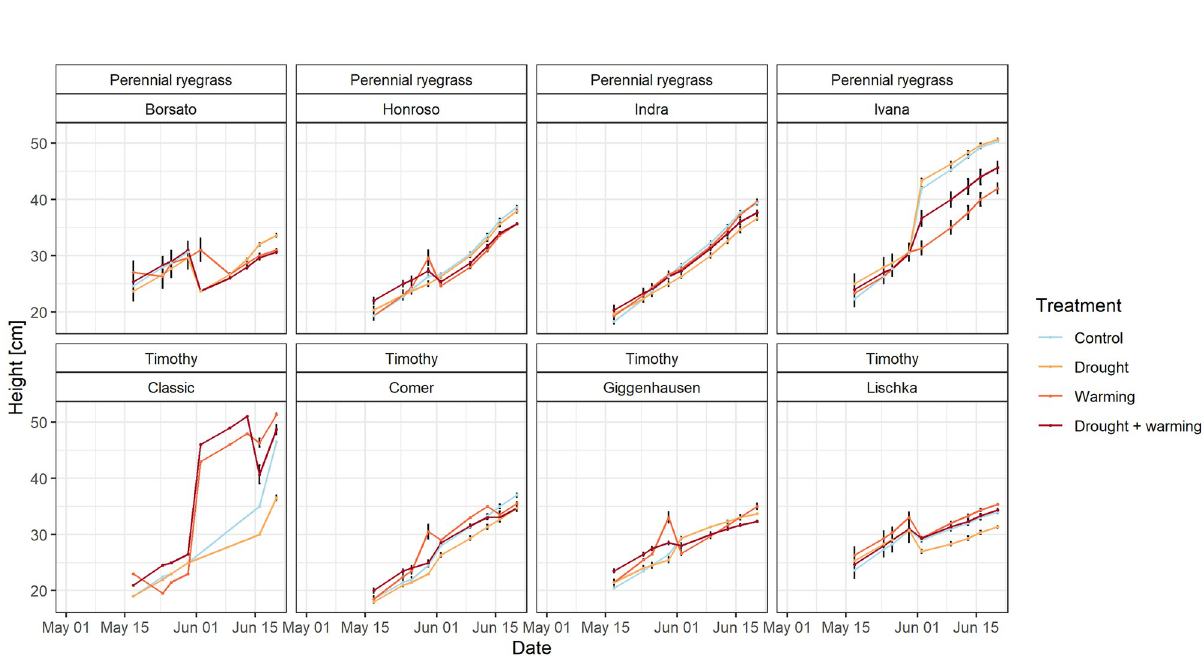
Fig 4. Height developments of the cultivars of perennial ryegrass and timothy between May 17 and June 23, 2017. Error bars indicate the standard error of three measurements each.